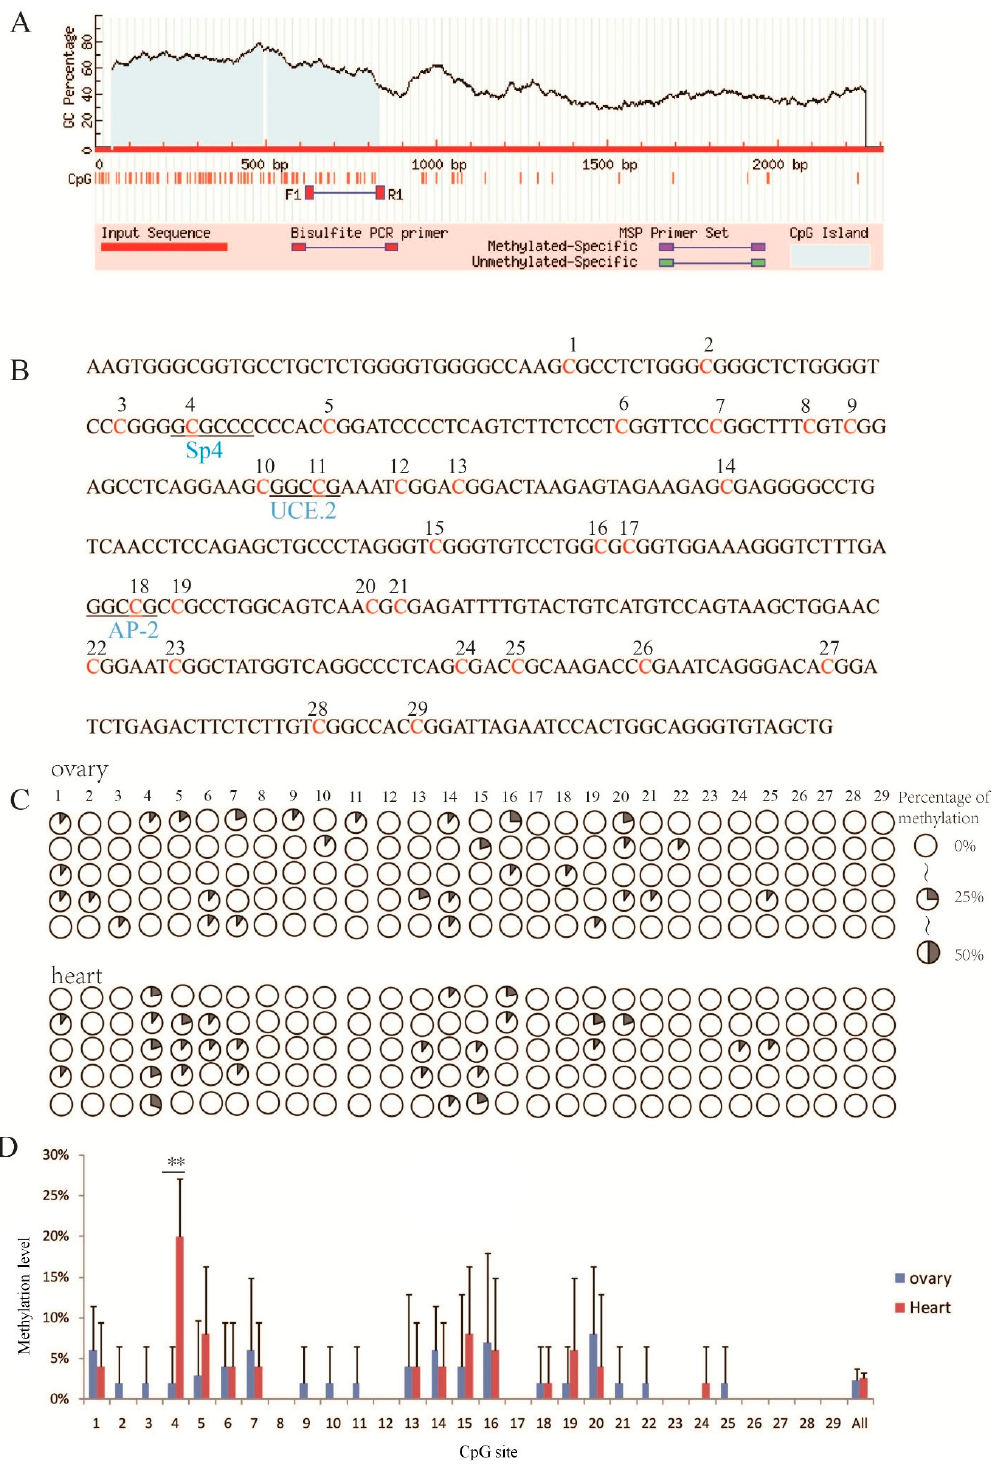
Figure 2. Methylation level of one CpG island ( − 1453 to − 1854) of ovine GDF9 in ovary and heart tissues. ( A ) The CpG island (sequences from F1 to R1) selected for methylation analysis. ( B ) The CpG site and transcription factor binding sites in this CpG island. A total of 29 CpG sites (each site is numbered above) and three transcription factor binding sites (Sp4, UCE.2, AP-2, each sequence is underlined) are included. ( C ) Methylation levels of CpG sites in ovary and heart. Rows represent tissue from the five STH sheep; columns indicate CpG site. The overall methylation level was relatively low, and the level of mC-4 in heart was relatively high (20%). ( D ) Histogram of methylation level of CpG sites. The mC-4 methylation level was significantly different (** p < 0.01) between heart and ovary, and mC-4 was coincidentally present on Sp4 transcription factor binding